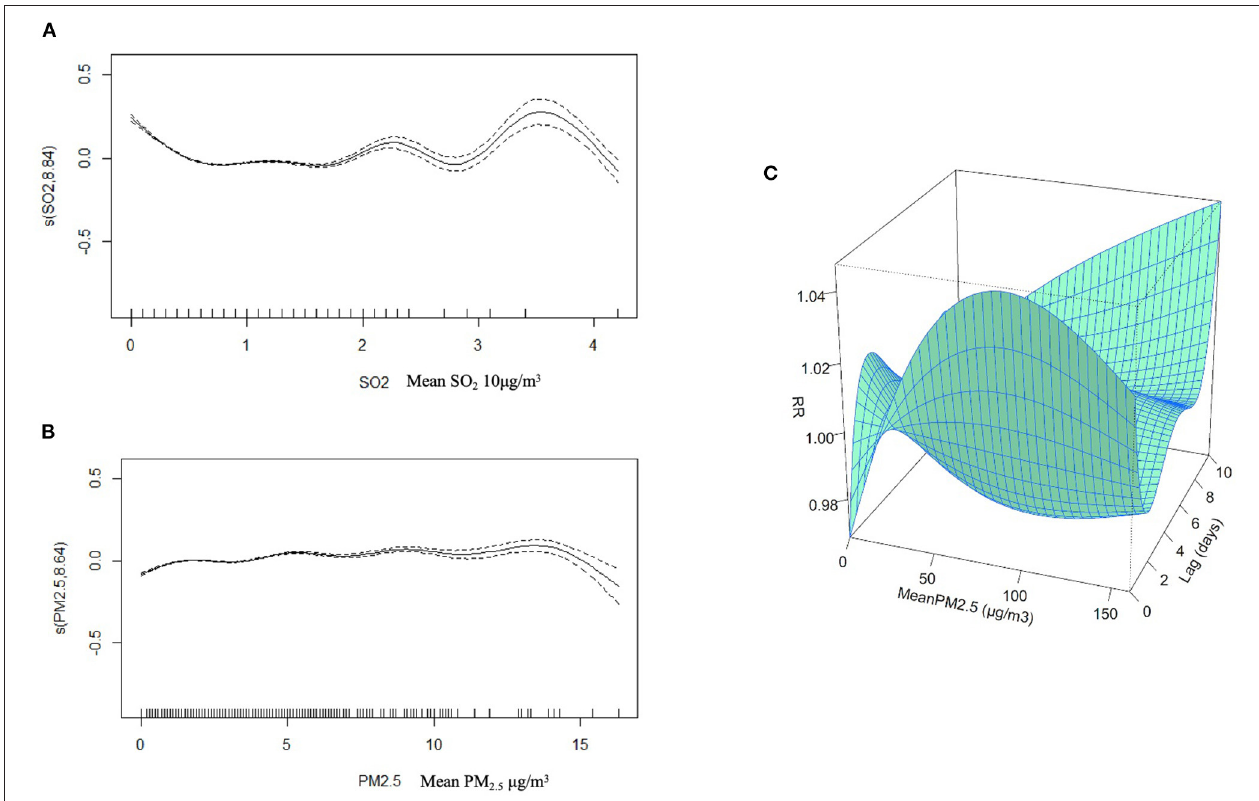
FIGURE 2 | Non-linear relationship between the PM 2.5 and daily internal medicine outpatient visits. (A,B) depict the visualization of the generalized additive model for SO 2 and PM 2.5 . The solid curve in the middle represents a non-linear relationship between the independent variable (SO 2 or PM 2.5 ) and the outcome (outpatient visits). For the three-dimensional (3D) (C) plot, the X-axis represents PM 2.5 concentration, the Y-axis represents the lag days, and the Z-axis represents the relative risk